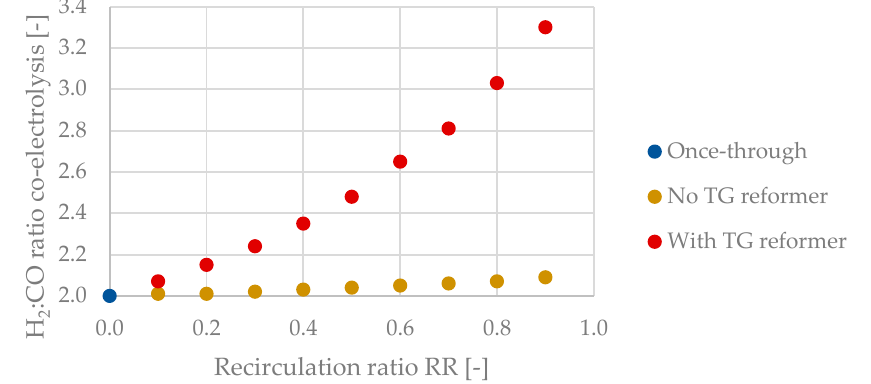
Figure 8. H 2 :CO ratio of the SOEC (co-electrolysis) unit with and without a tail gas reformer.